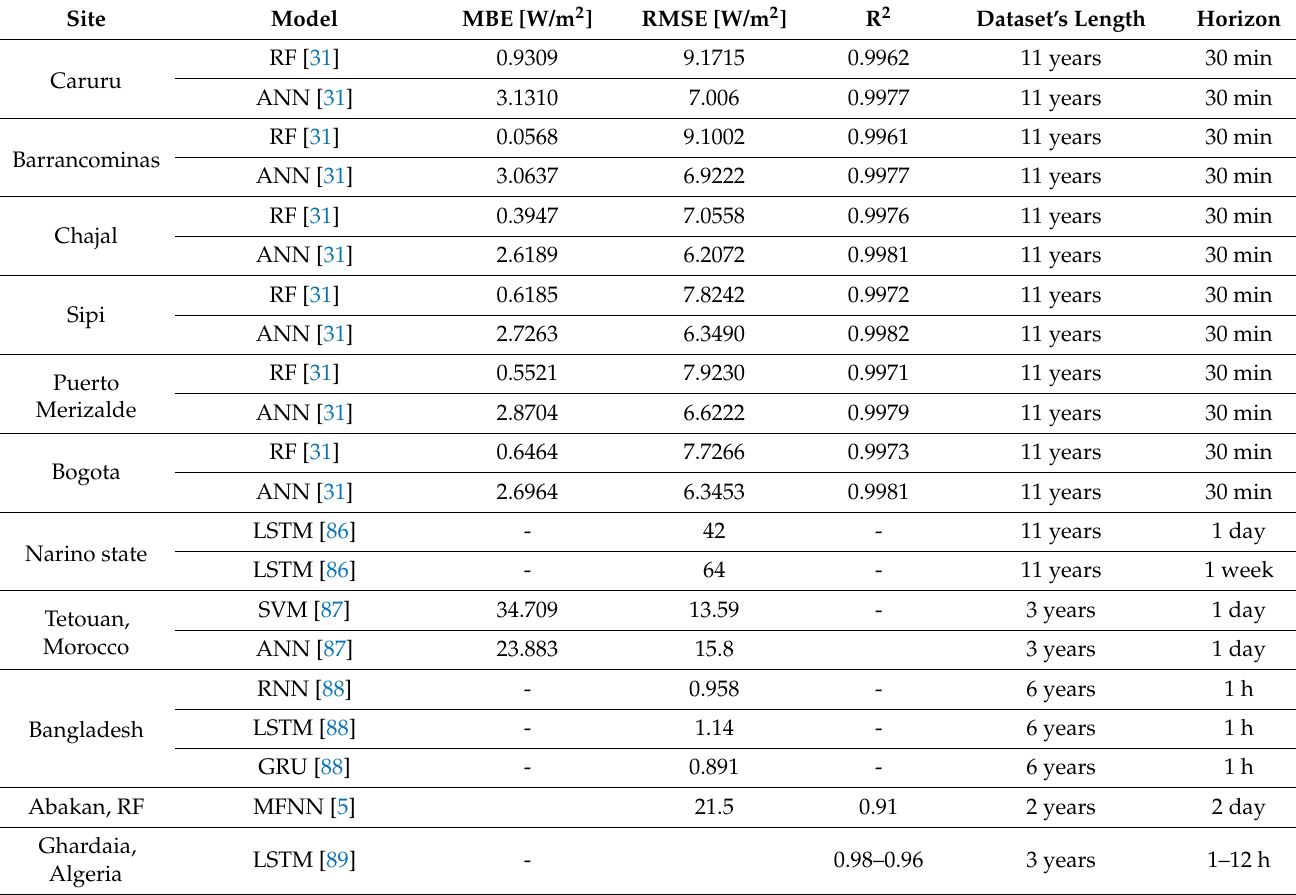
Table 8. The performances of the insolation forecasting ML